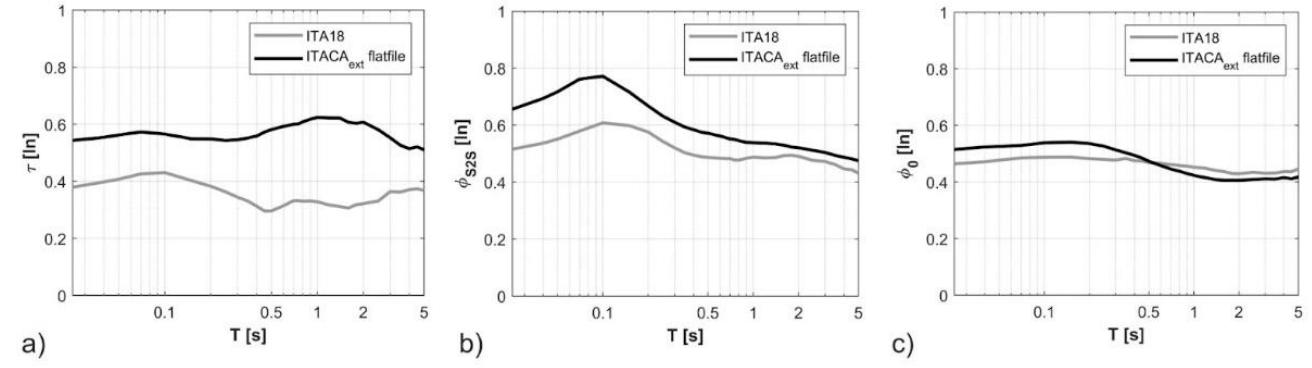
Figure 4. ITA18 versus ITACAext flatfile variability. ( a ) Between-event standard deviation, τ ; ( b ) site-to-site standard deviation, Φ S 2 S , and ( c ) event- and site-corrected standard deviation, Φ 0 .